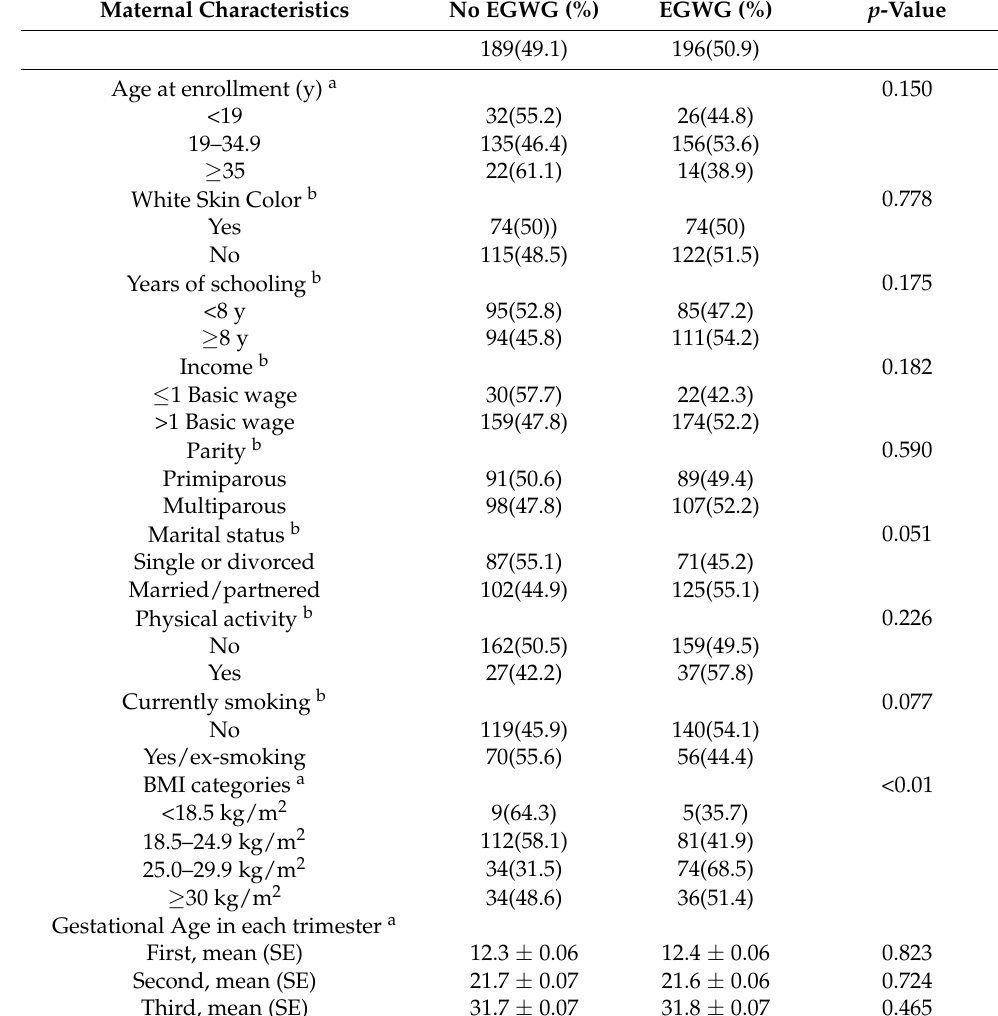
Table 1. Sociodemographic, maternal characteristics, and gestational age in each trimester with respect to excessive gestational weight gain in the ProcriAr cohort, S ã o Paulo, 2011–2013. Maternal Characteristics No EGWG (%) EGWG (%) p -Value 189(49.1) 196(50.9) Age at enrollment (y)